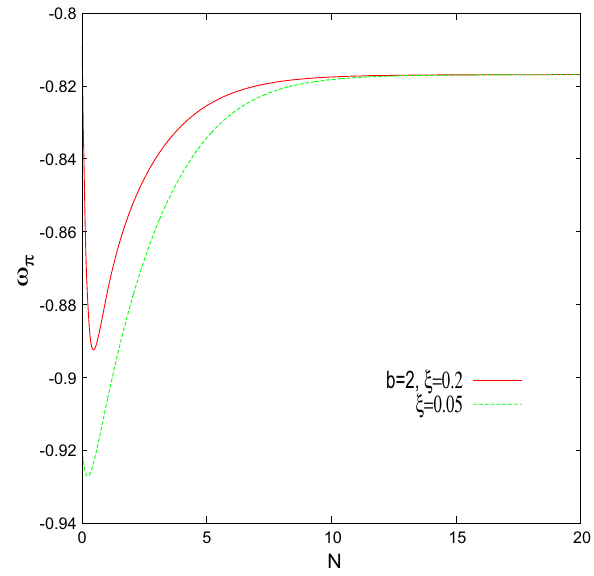
Fig. 9 A graph of ω π vs. N for different values of ξ , where b = 2 is chosen to retain the stability of a fixed point